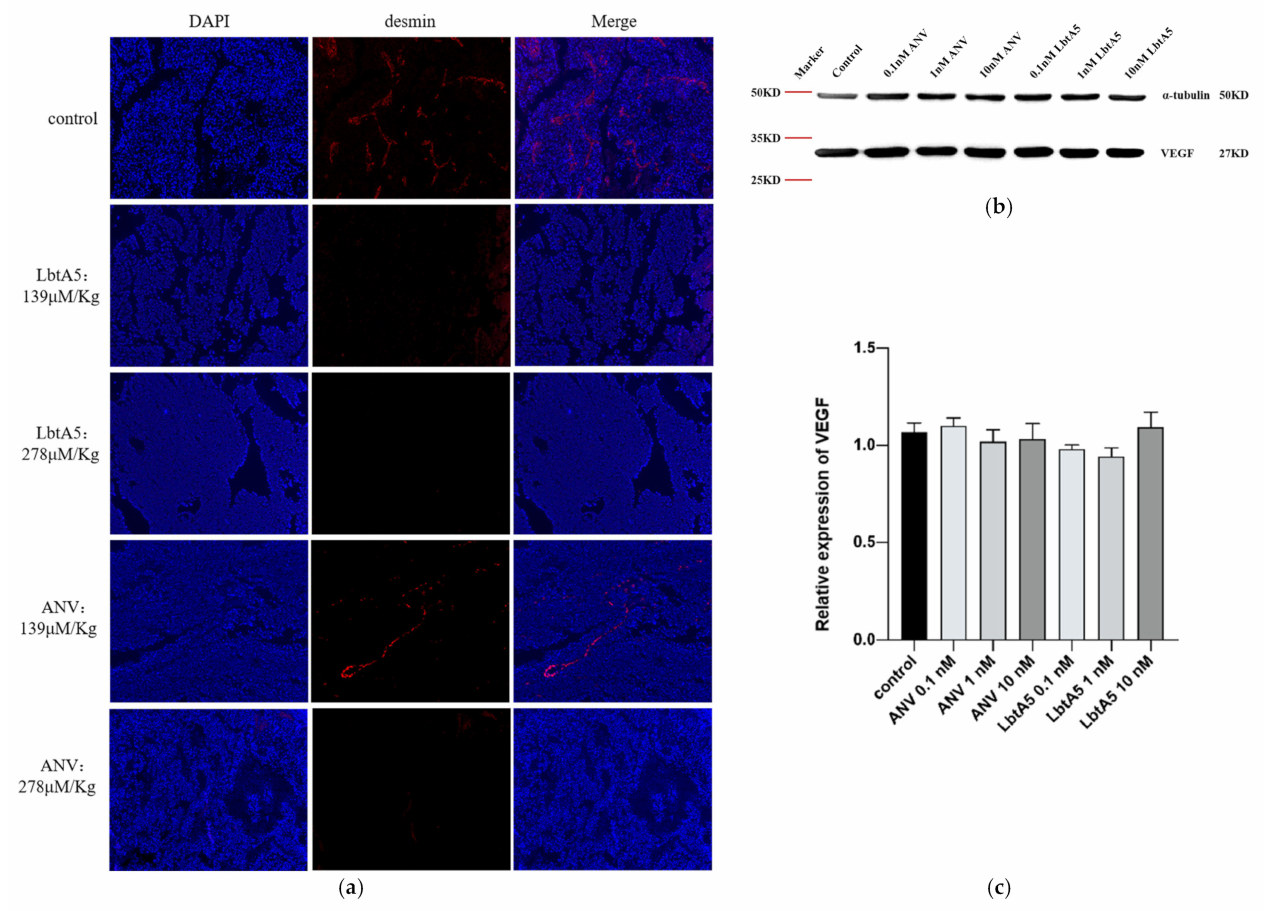
Figure 6. ANV and LbtA5 inhibited tumor angiogenesis. ( a ) Fluorescence images of tumor blood vessels. Vesicular staining (immunofluorescence) was performed and showed colocalization of desmin (red) in PBS-treated samples. The fluorescence distribution was photographed at a 555 nm wavelength with an inverted fluorescence microscope at 100 × ; ( b ) The effect of ANV and LbtA5 on the VEGF protein expression of B16F10 cells monitored by Western blot analysis; ( c ) Western blot grayscale data analysis (normalized using ImageJ software), VEGF relative expression = VEGF expression/internal reference protein expression, using one-way ANOVA, mean ± SEM, n = 3, ns for p > 0.05, all compared to control protein-free